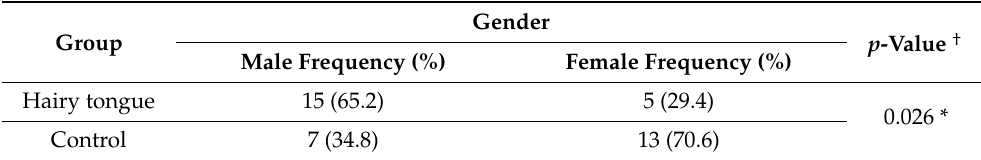
Table 2. Distribution of the hairy tongue lesions according to the gender in the hairy tongue group and the control group.